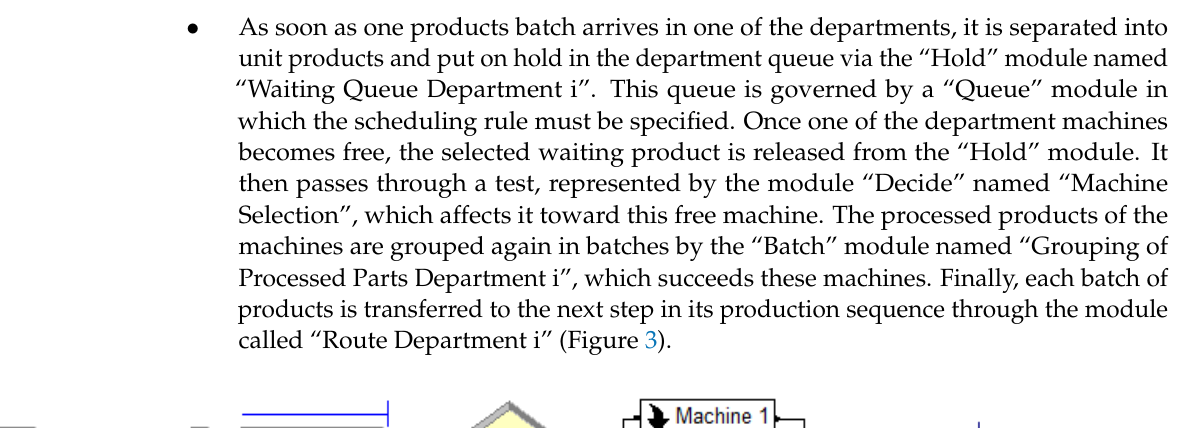
Figure 3. Simulation part model related to department “i”.